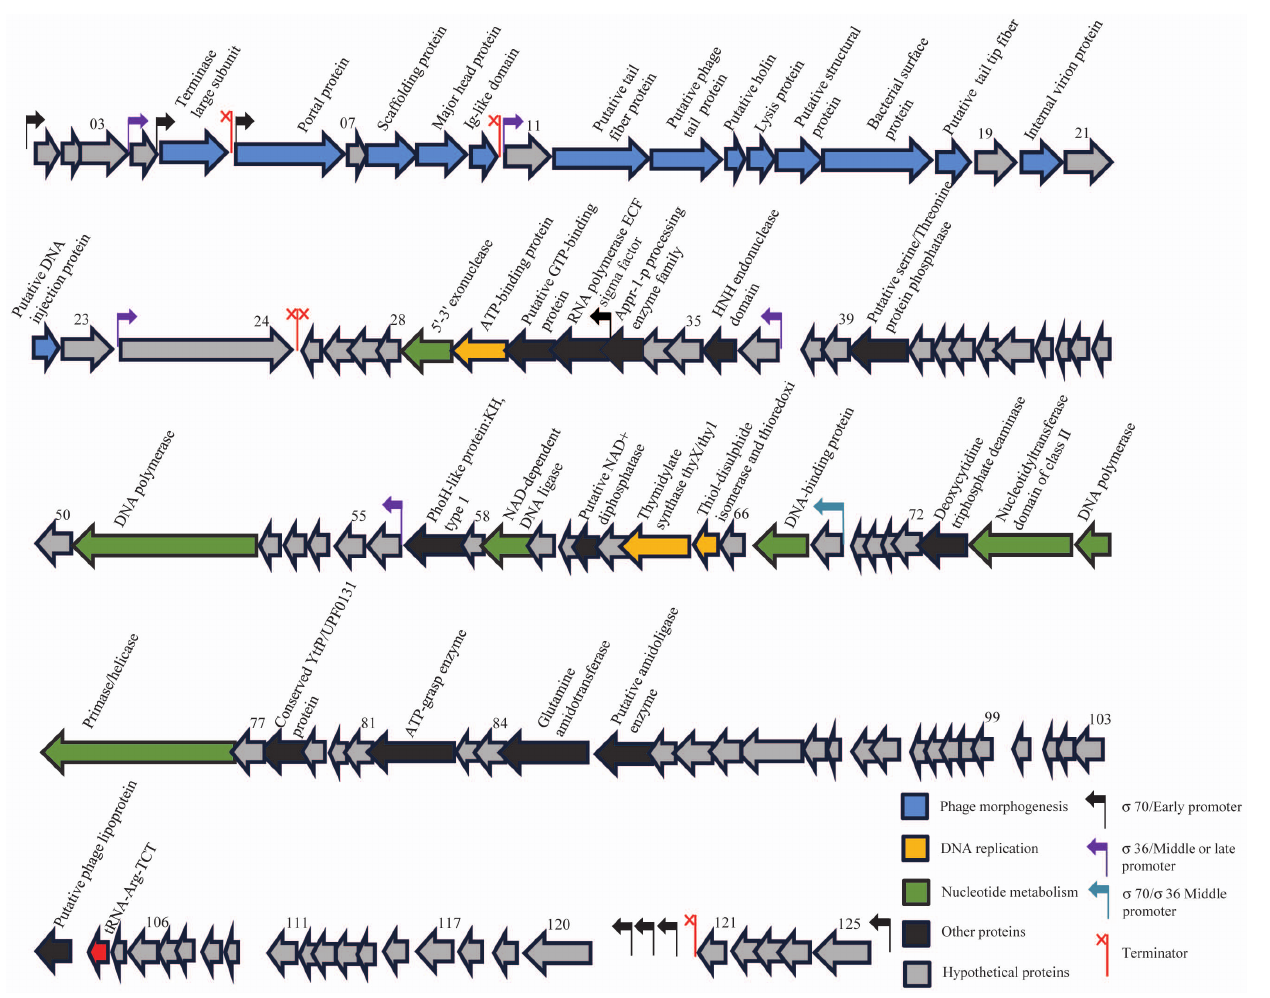
Fig. 2. The genome of phage SU10. The predicted CDSs are indicated by arrows, and the directions of arrows indicate direction of transcription. 28% of the predicted proteins were identified in our mass-spectrometry based proteomics. CDSs predicted to encoding structural proteins are indicated in blue, hypothetical proteins in grey, DNA replication and recombination proteins in green. Genes predicted to encode enzymes involved in nucleotide metabolism are indicated in yellow, black is showing other